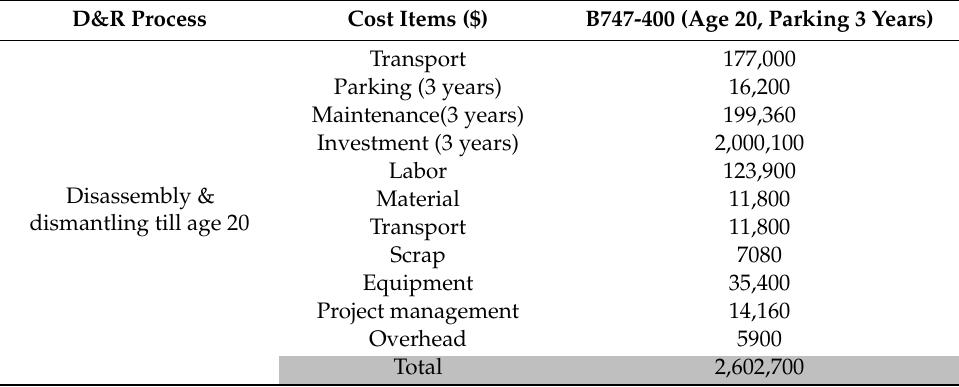
Table 10. Disposal and recycle costs for 747-400 disassembly and dismantling till age 20 (2005 USD).